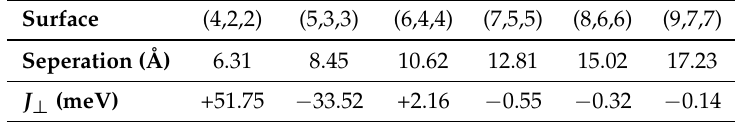
Table 2. Exchange coupling constants ( J ⊥ ) of Fe wires on Cu(111) stepped